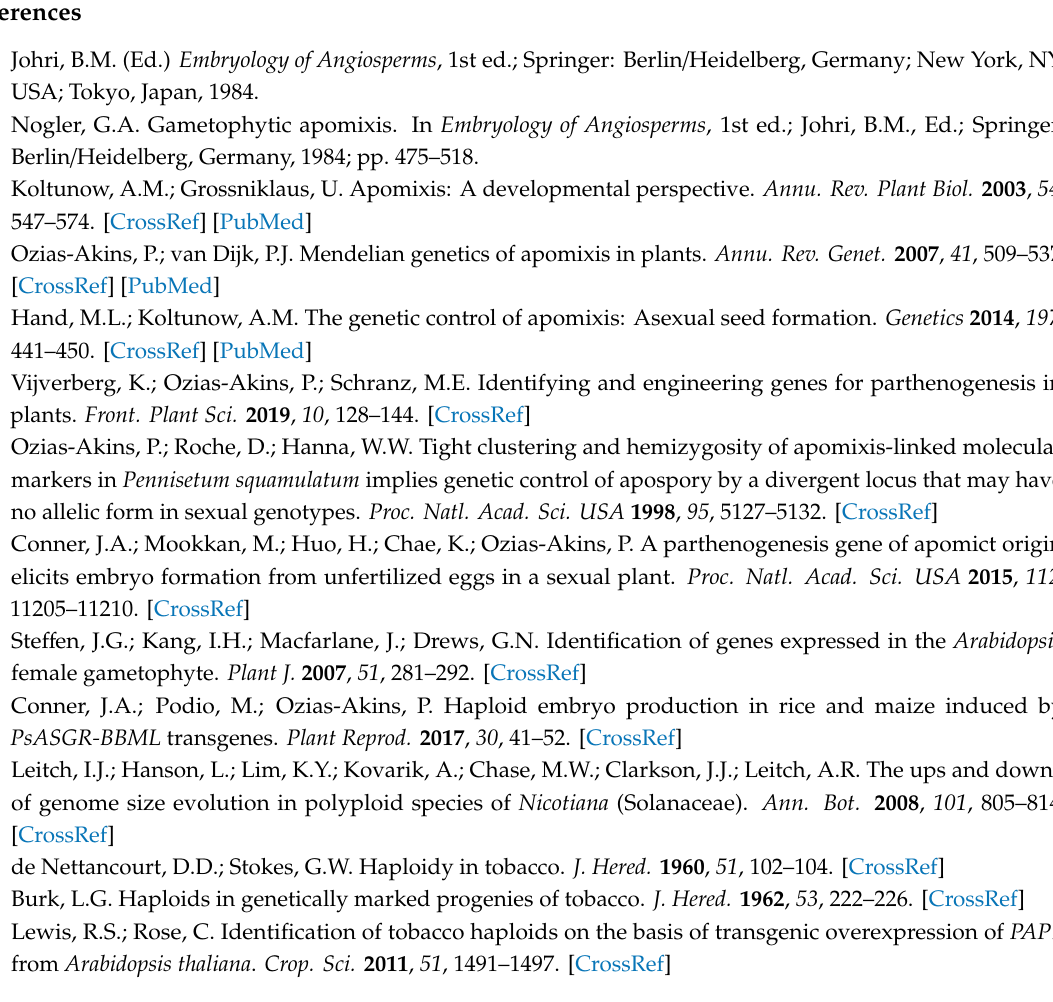
Figure S1: Flow cytometric seed screen (FCSS) analysis identified T0 plants that produced haploid progeny; Figure S2: Expression of the PsASGR-BBML transgene in the ovules from the haploid-producing 4 x T1 of RKD2gBB_6.1 compared with non-haploid-producing RKD2gBB T0 lines; Table S1: Sequences of primers used for PCR; Table S2: T0 lines randomly selected to verify expression of the PsASGR-BBML transgene in ovules of flowers at developmental stage 11 by RT-PCR; Table S3. Genetic segregation and copy number estimate of the transgenes in the haploid-producing T0 lines; Table S4. Genetic segregation and copy number estimate of the transgenes in T1 progeny of line RKD2gBB_6.1; Table S5. Genetic segregation in progeny of a cross between a 4 x RKD2gBB_6.1 T1 and non-transgenic